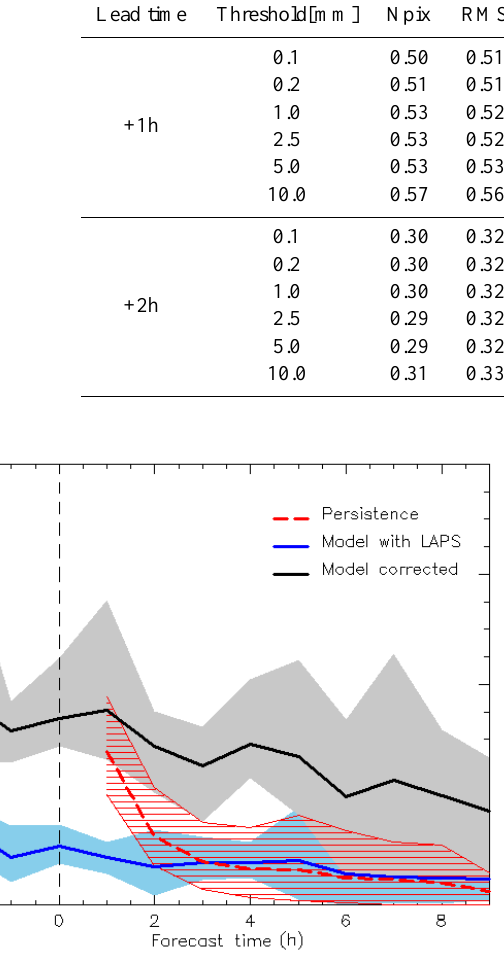
Fig. 4. Correlation of observation with the persistence (red), model (blue) and model corrected (black) as a function of forecast time. The shaded areas represent the range of results whereas the solid line is the mean of the seven case studies.